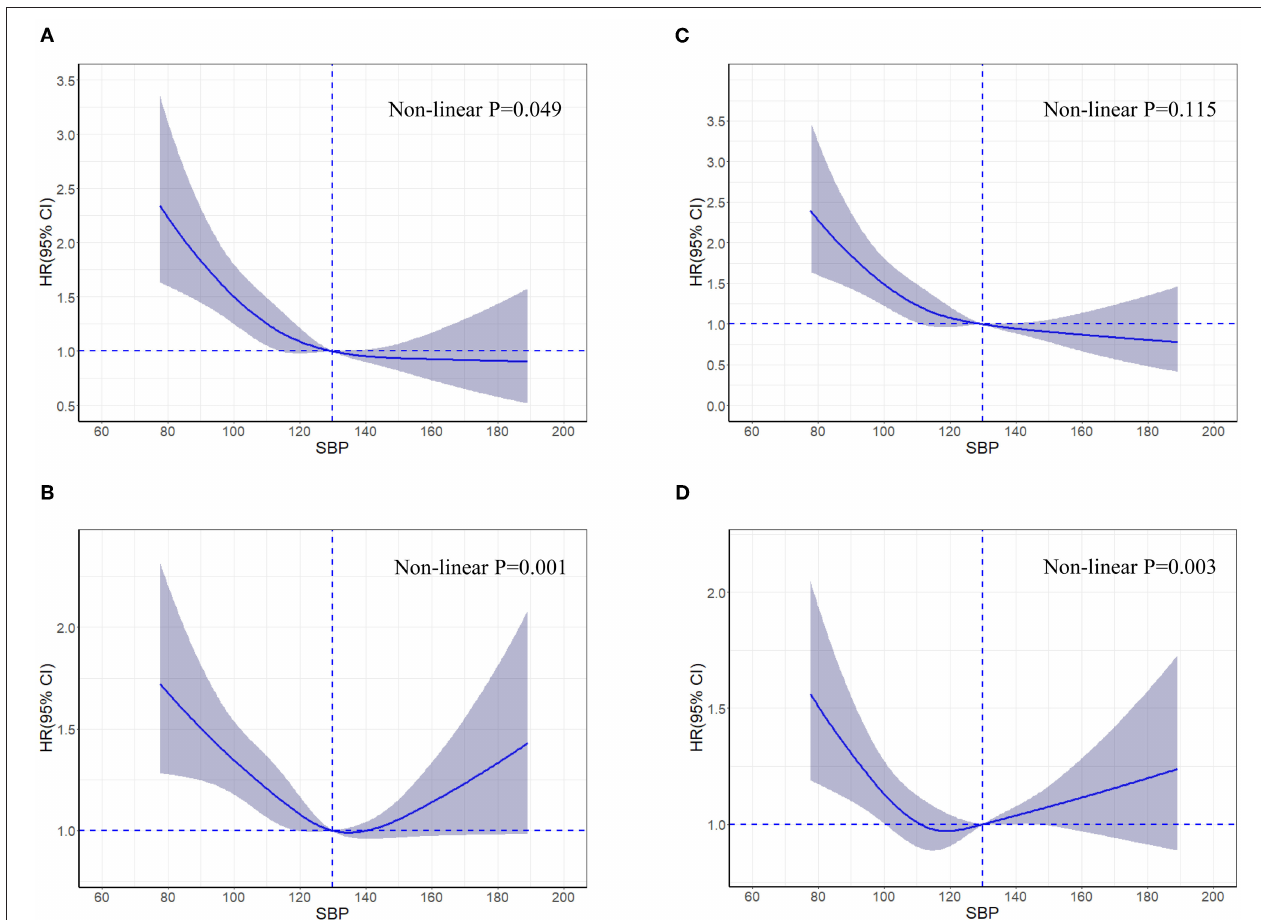
FIGURE 2 | Restricted cubic spline curves for an association between systolic blood pressure and all-cause death (A) , heart failure readmission (B) , cardiovascular death (C) , and all-cause hospitalization (D) in patients hospitalized for heart failure. Hazard ratios and 95% confidence intervals for clinical outcomes by systolic blood pressure groups in 4,564 patients hospitalized for heart failure according to restricted cubic spline regression models using four knots at systolic blood pressures of 95, 115, 129, and 157 mmHg. SBP of 130 mmHg was applied as the reference. Solid blue lines indicate hazard ratios, and shaded areas indicate 95% confidence intervals. CI, confidence interval; HR, hazard ratio; SBP, systolic blood